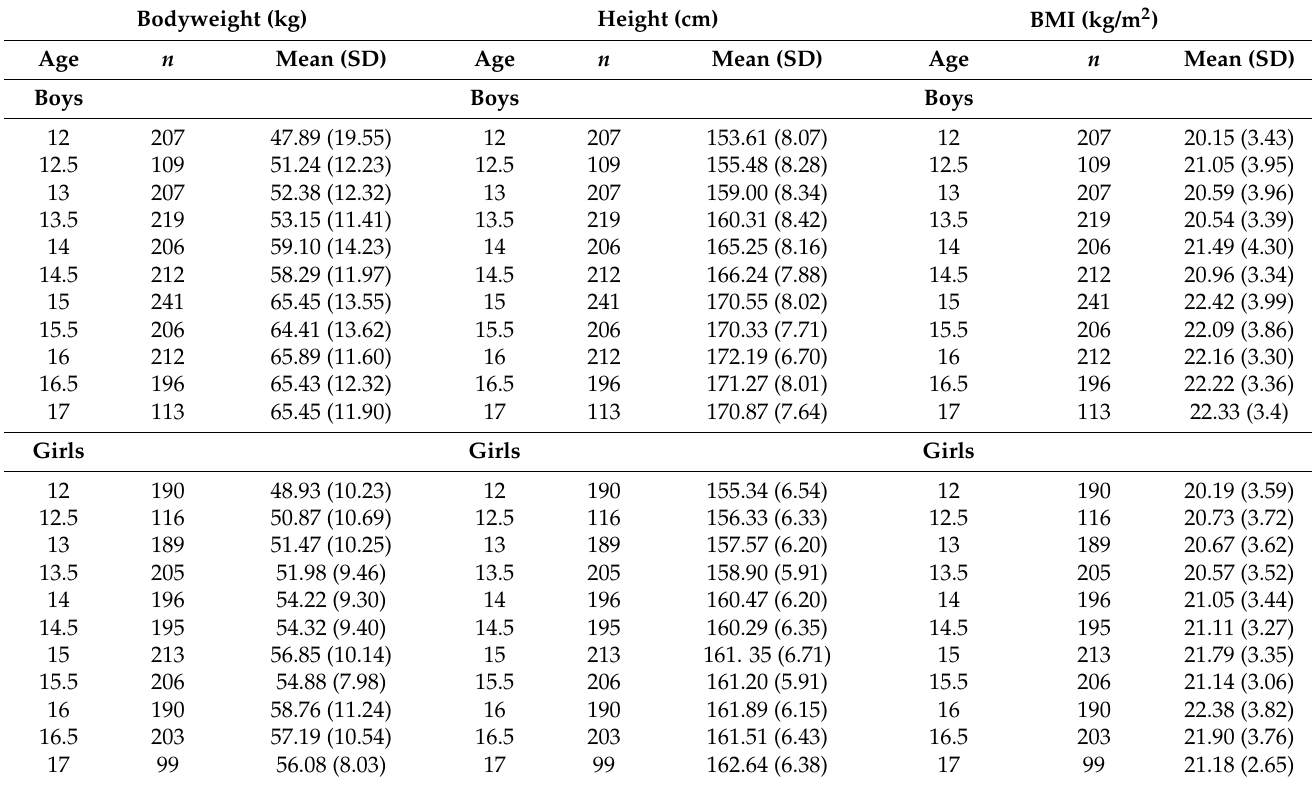
Table 1. Participants’ anthropometry stratified by age and